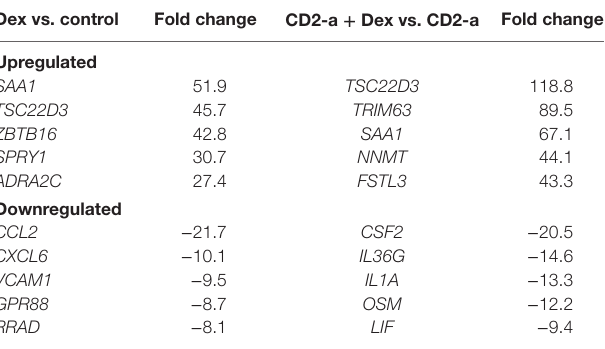
TaBle 1 | Genes upregulated and downregulated by Dex. Dex vs. control